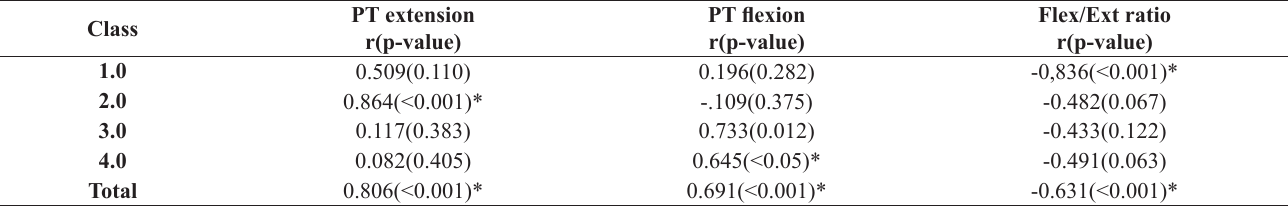
Table 4. Correlation of isokinetic variables stratified by WCB classes.